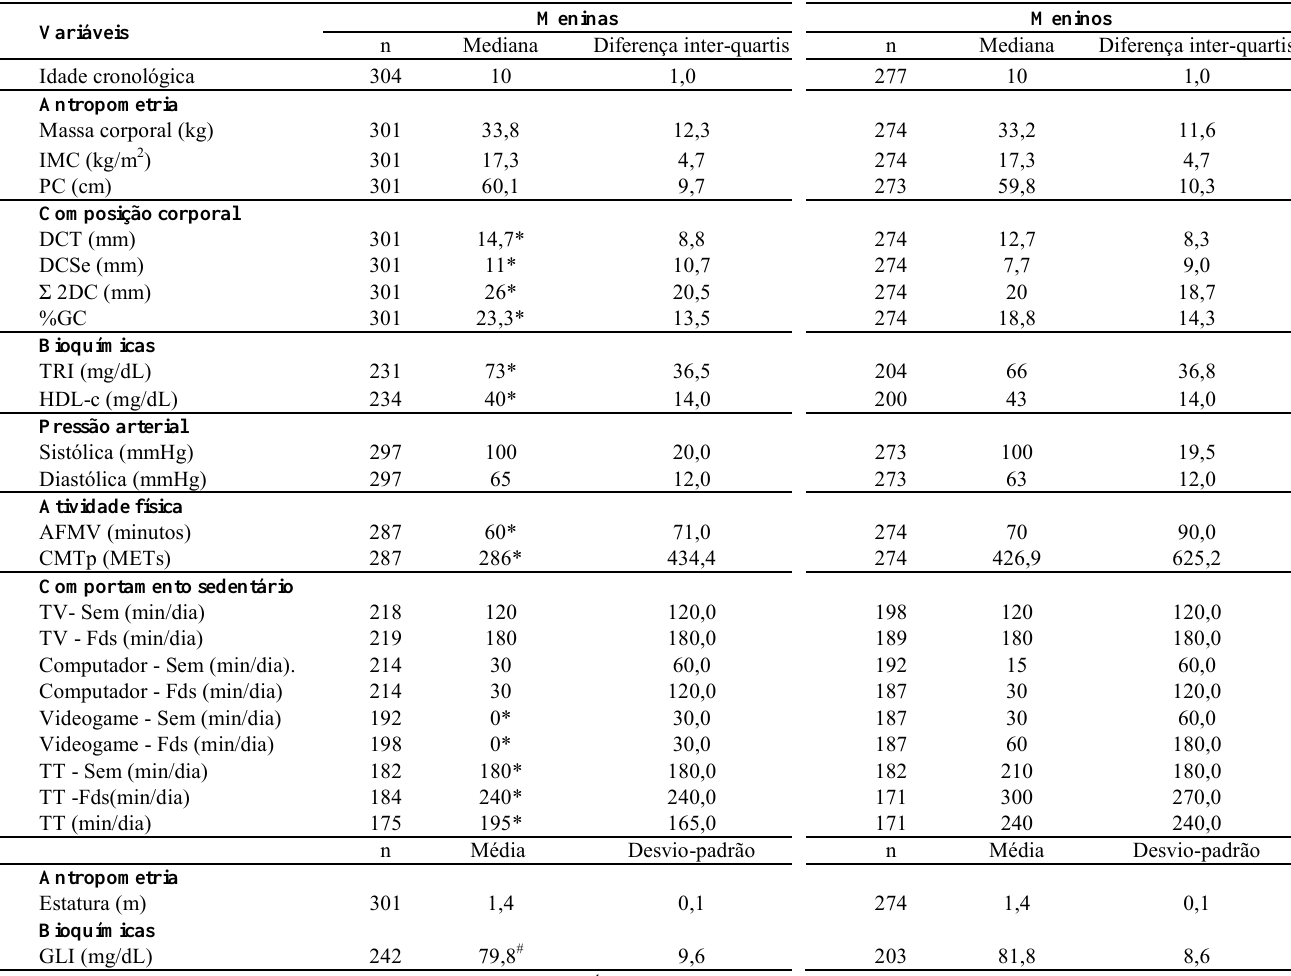
Tabela 1. Caracterização das variáveis antropométricas, de saúde e comportamentais dos escolares de 9-12 anos de idade do município de Uberaba, MG, Brasil,